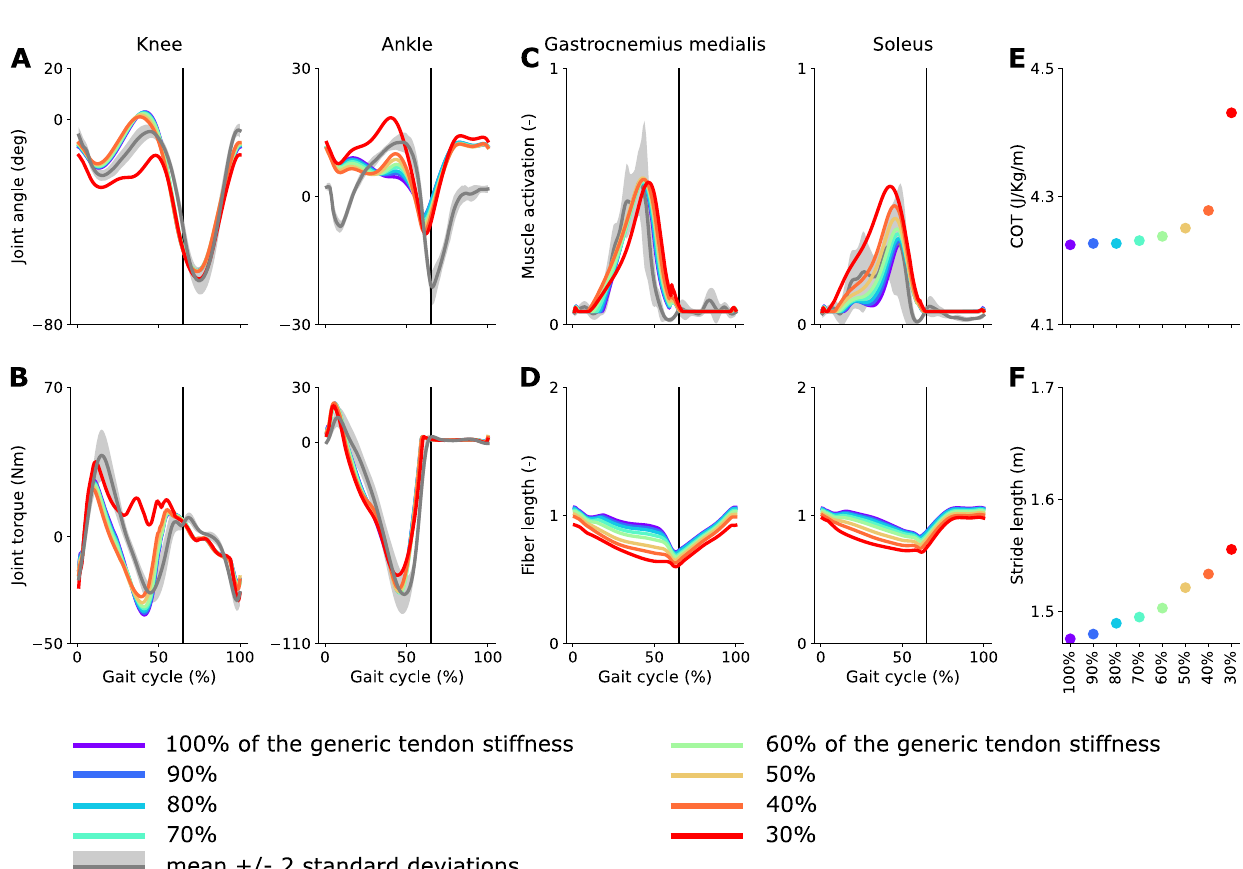
Fig 3. Influence of Achilles tendon stiffness on predicted gait pattern. Predicted knee and ankle kinematics ( A ) and kinetics ( B ), triceps surae activations ( C ), and normalized muscle fiber lengths ( D ) with models with different Achilles tendon stiffness. Predicted metabolic cost of transport ( E ) and stride length ( F ) as a function of the Achilles tendon stiffness (in percent of the nominal value). Experimental data (shaded areas) are shown as mean ± 2 standard deviations. The experimental electromyography data were normalized to peak nominal activations (100% of the generic Achilles tendon stiffness). The vertical black lines indicate experimental stance to swing